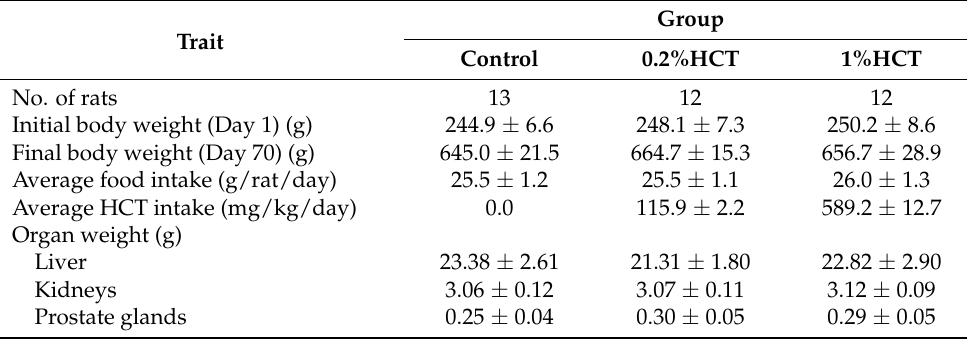
Table 3. Incidence of carcinoma and the percentage of prostatic neoplastic lesions in TRAP rat treated with HCT. Treatments